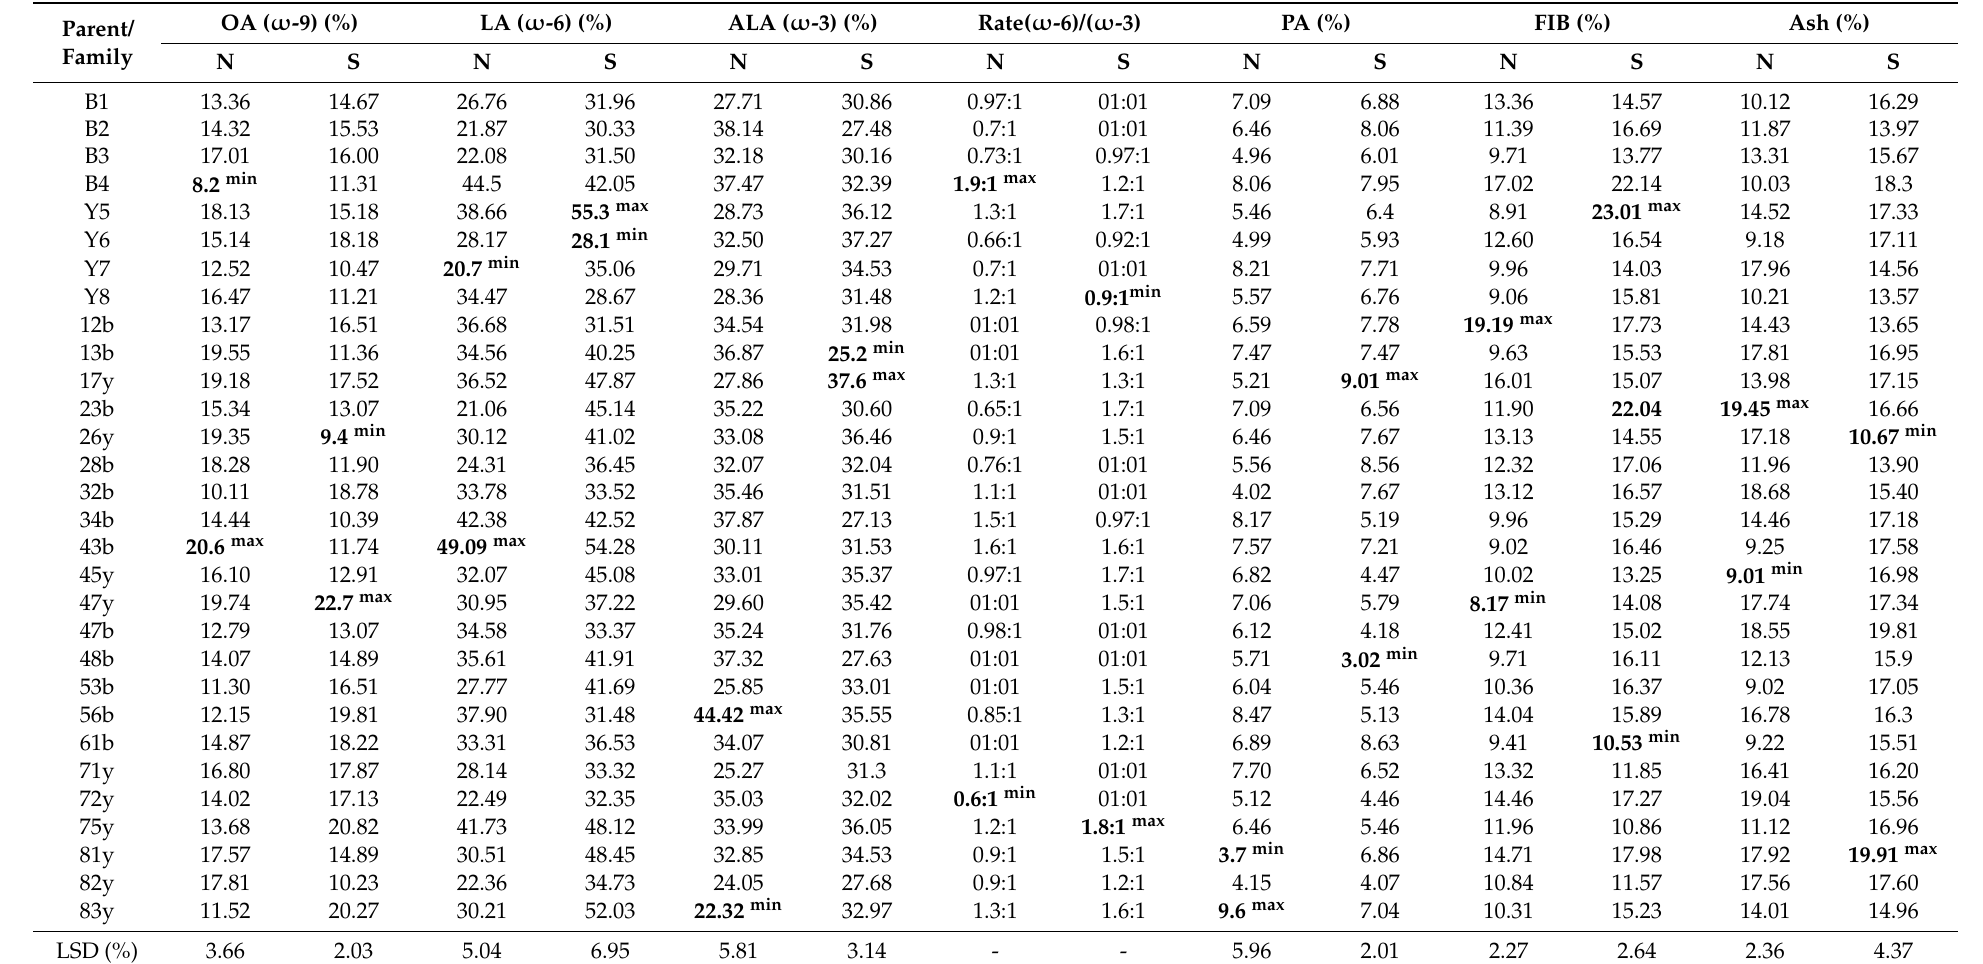
Table 4. Means of quality traits (NIR) in parents and families of flax under control and intense drought stress (IDS). Parent/